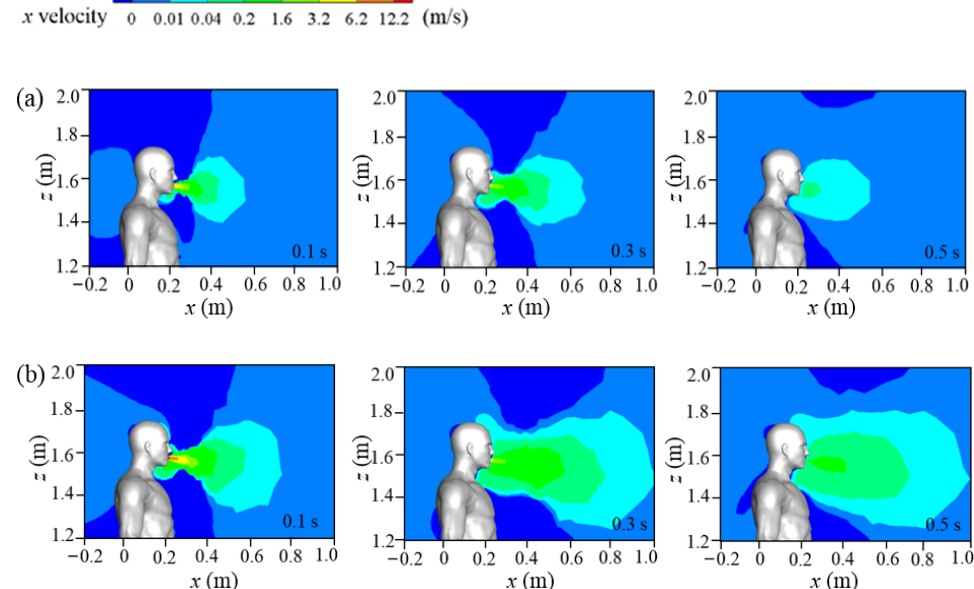
Figure 6. Flow fields of the cough jet in a calm wind environment: ( a ) standard cough jet at different times; ( b ) double-strength cough jet at different times.